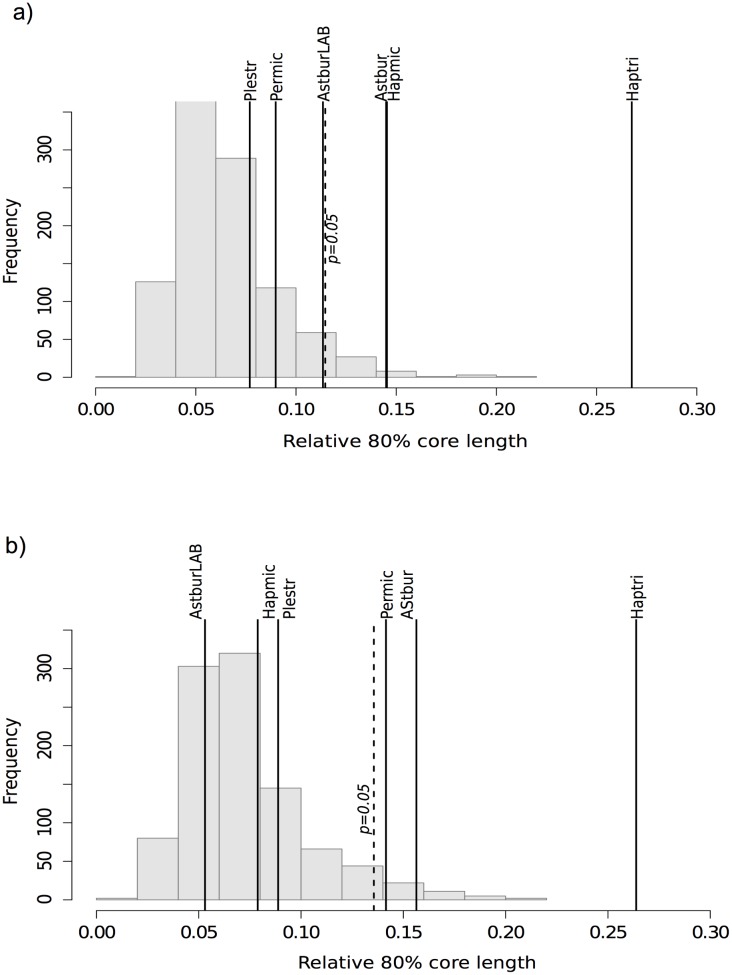
Observed intraspecific core length (i.e. relative proportion of shared OTUs across 80% of conspecifics, shown as vertical lines), compared to random sampling of the whole dataset (barplots, 1000 permutations, p<0.05) for V12 (a) and V34 (B).There is a general trend for increase relative core length among conspecifics compared to random individuals, with few species carrying a significantly larger core in one or both libraries (Astbur, Haptri, Hapmic and Permic, p<0.05). Perecc was excluded from the analysis because it contributed with only one individual.